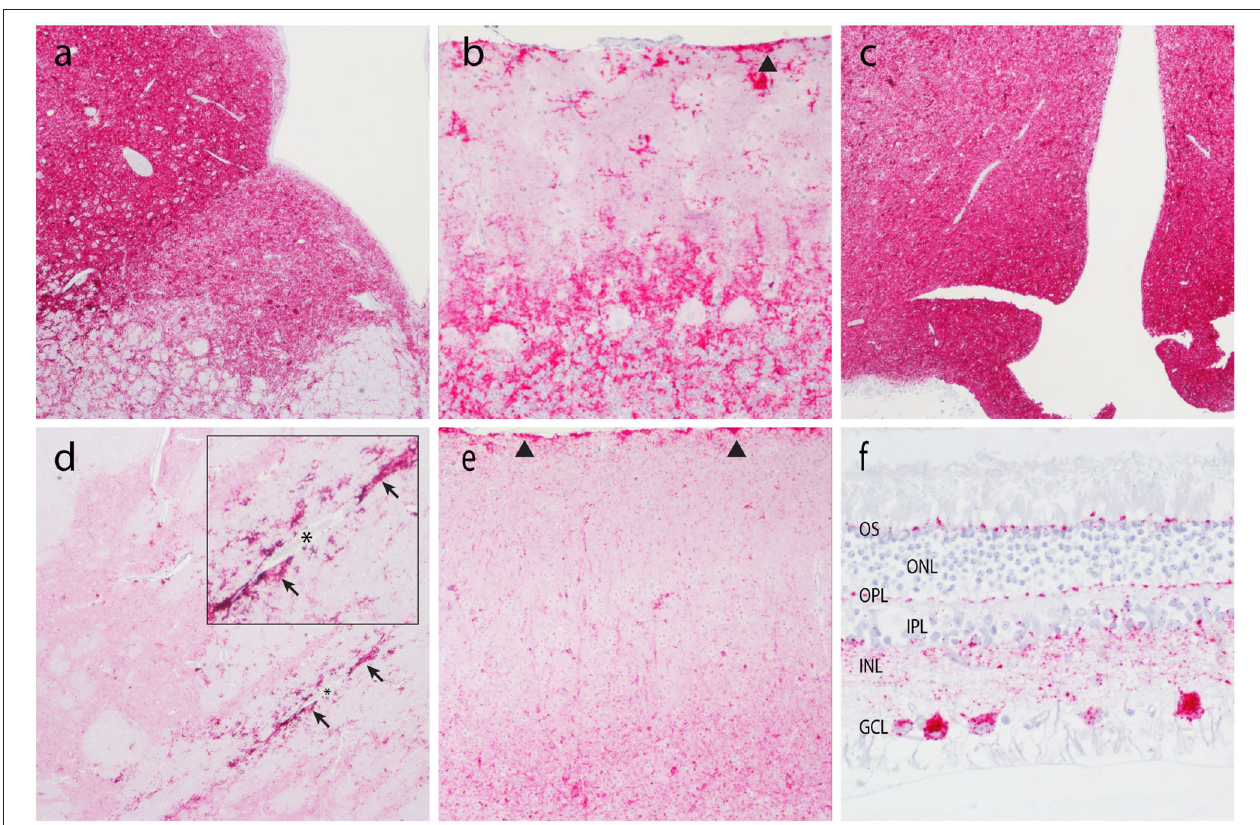
FIGURE 2 | Accumulation of PrP Sc in the central nervous system. Representative micrographs show PrP Sc immunoreactivity in the brainstem at the level of the obex ( a , 4 × ), cerebellum ( b , 20 × ), thalamus/hypothalamus ( c , 4 × ), basal nuclei ( d , 4 × ), neocortex ( e , 10 × ), and retina ( f , 40 × ). Note subpial immunolabeling (arrowheads) in the cerebellum (b) and neocortex (e) , and prominent perivascular glial-associated immunolabeling (arrows) around a blood vessel (*) in the white matter of the internal capsule (d) . Obex, neocortex, and the retina are from animal O68. Cerebellum, internal capsule, and thalamus are from animal B186. OS, outer segments; ONL, outer nuclear layer; OPL, outer plexiform layer; IPL, inner plexiform layer; INL, inner nuclear layer; GCL, ganglion cell